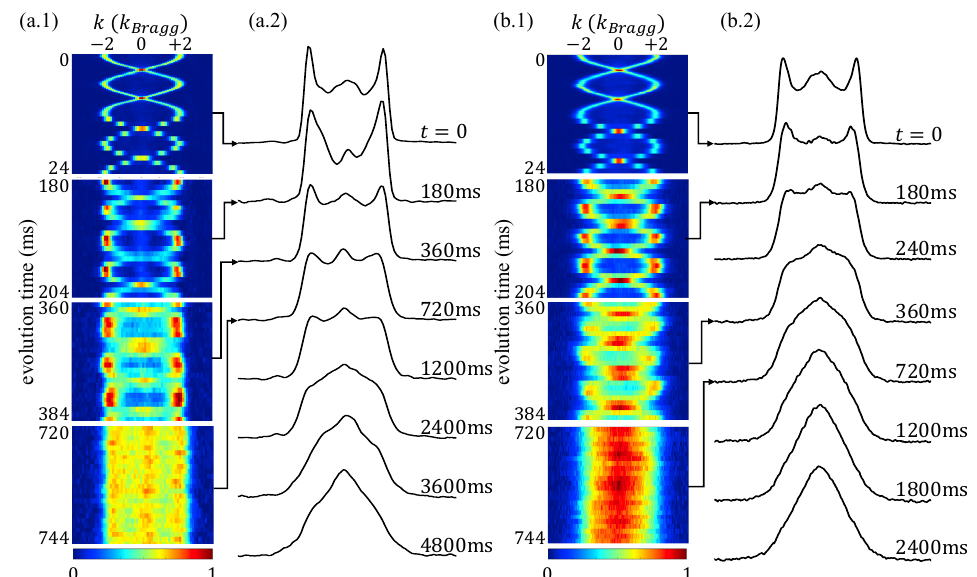
Figure 5: Basic observations: MDF for dynamics starting with ± 2 k Fig. 3 (a) and (b)). (a.1, b.1) Four segments of the dynamics of MDF starting from the 1st period (upper), the 15th, 30th to the 60th period (bottom) for N = 40 (a) and N = 130 (b). Each segment includes two oscillation periods. The time resolution of the measurements in the first period is finer than the following measurements by a factor of 5. One clearly observes a blurring of the oscillations which can be attributed to dephasing. (a.2, b.2) Time evolution of the oscillation period averaged MDF F ( t , k ) : for N = 40 (a) and N = 130 (b). For long times the MDF relaxes towards a Gaussian